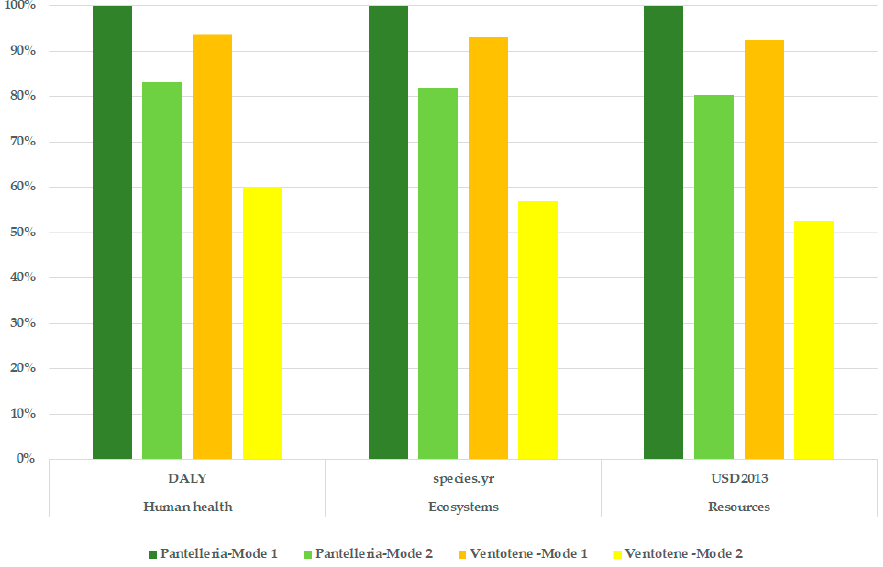
Figure 6. Impact characterization for the different batteries in the alternative scenario and for the reference case (ReCiPe 2016 method-Endpoint (H)).